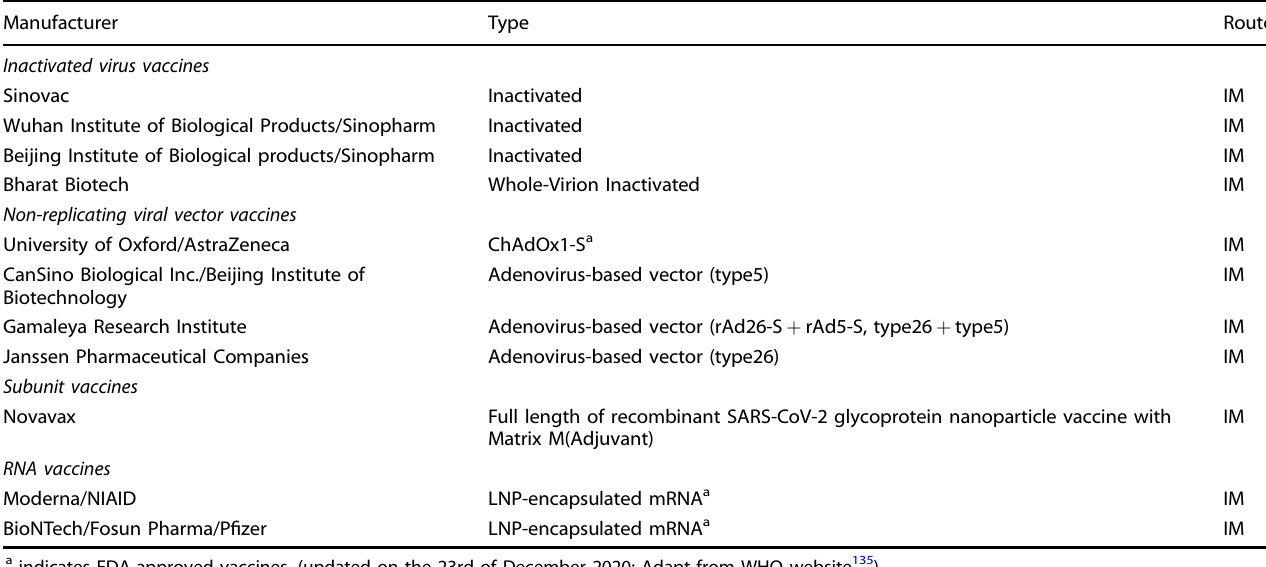
Table 2. The current COVID-19 vaccines under phase 3 clinical trials or FDA-approved for COVID-19. IM indicates intramuscular